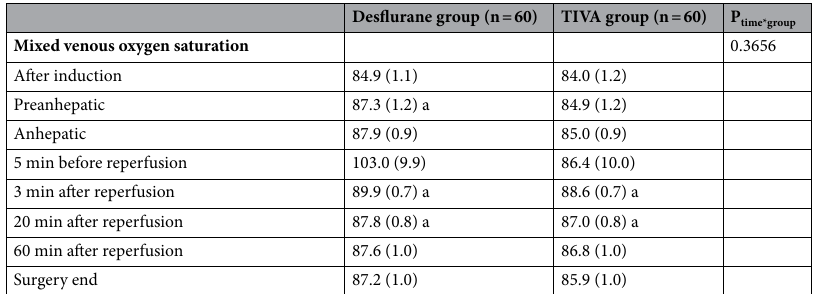
Table 3. Intraoperative hemodynamic data. Data are presented as estimated mean (standard error). TIVA, total intravenous anesthesia. a Bonferroni-corrected P < 0.05 compared with the value of baseline (before